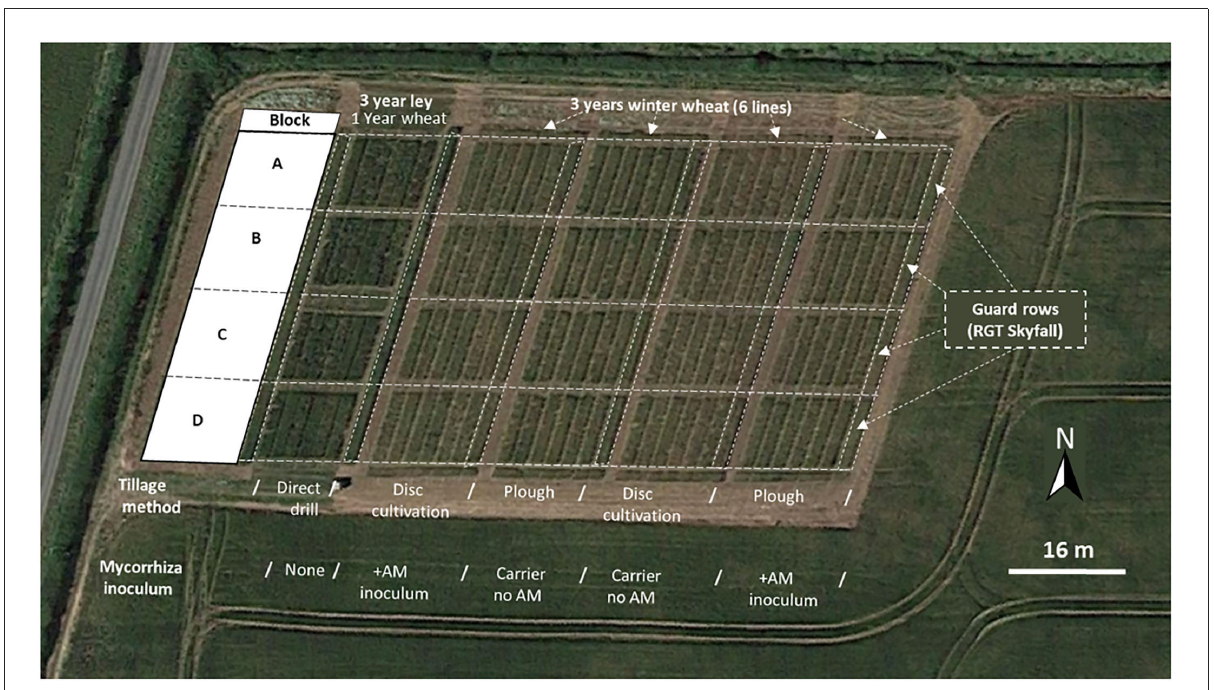
FIGURE1 Aerial view (June 2018) of the experimental plots arranged in four blocks (A-D) running downslope at Spen Farm, Tadcaster (53 ◦ 51’ 44” N; 1 ◦ 20’ 35”W). The image shows the wheat direct drilled into a 3-year ley compared to plots that have been cultivated and cropped with wheat for 3 successive years, with Skyfall wheat guard rows and the surrounding field which is not part of the trial. Map data © 2018